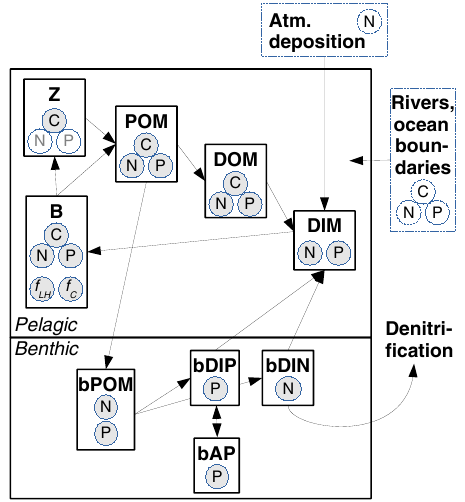
Figure 2. Structure of the biogeochemical model. Model compo- nents (rectangles) comprise the following. B is phytoplankton, Z is zooplankton, POM and DOM are particulate and dissolved or- ganic matter, DIM (N, P) is dissolved inorganic matter (nitrogen and phosphorus), and bAP is the P adsorbed in iron–phosphorus com- plexes (see Sect. 2.2.1 and Appendix A for further details). C, N and P in small circles refer to carbon, nitrogen and phosphorus bound to each component, respectively, whereas f LH and f C are the alloca- tion coefficients for light harvesting and carboxylation (Sect. 2.2.1). Boxes in dashed lines indicate model